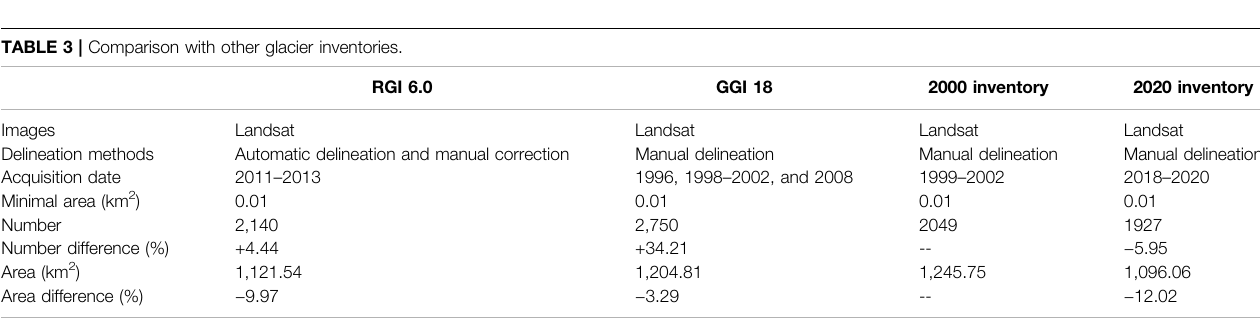
TABLE 3 | Comparison with other glacier inventories.